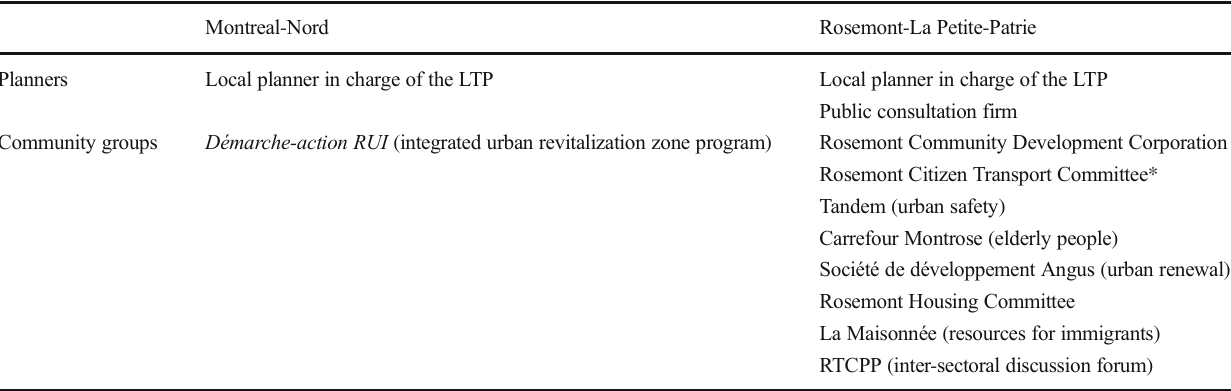
Local planners and community groups represented in formal and informal interviews for each borough. For Rosemont-La Petite-Patrie, the community groups in bold are the ones that attended the consultation meeting of the LTP Montreal-Nord